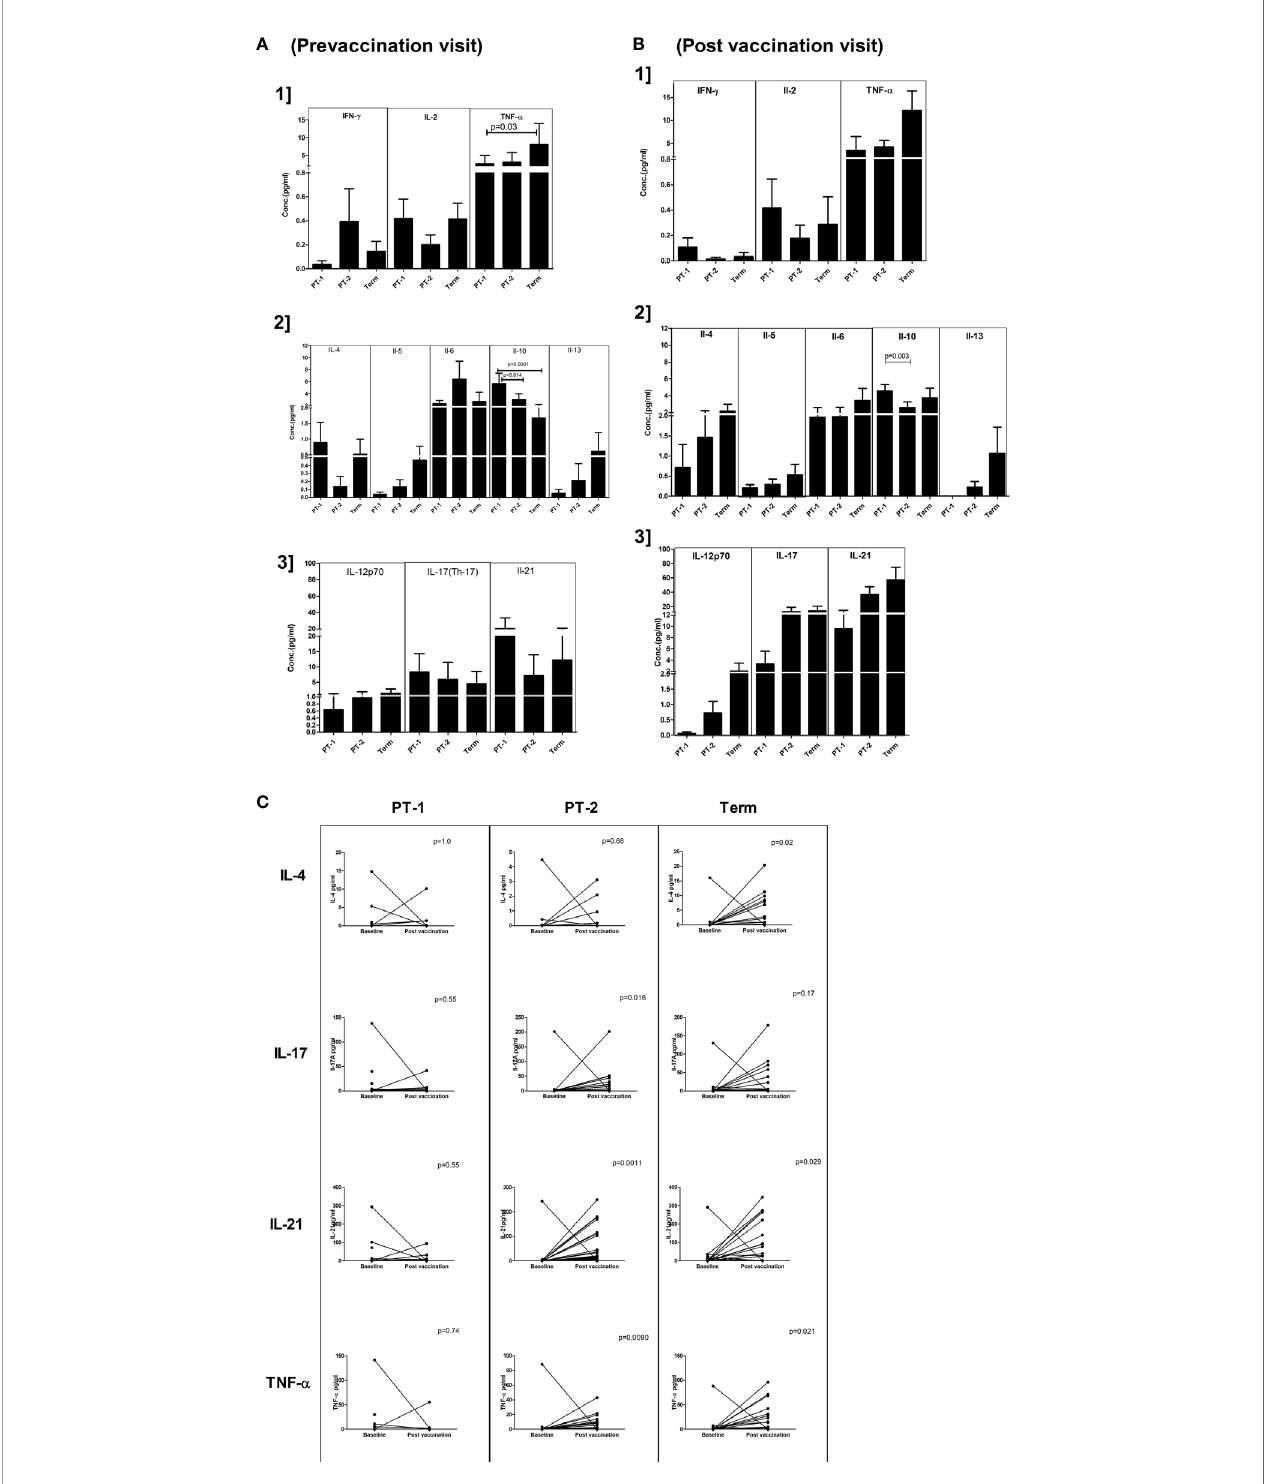
FIGURE 6 | Plasma cytokine levels in PT1, PT2 and FT infants prior to (A) and post- (B) pentavalent vaccination. The vertical column bar graphs represent A1] Th1 cytokines (IFN- g , IL-2, TNF- a ), A2] Th2 cytokines (IL-4, IL-5, IL-6, IL-10, IL-13) and A3] Th17 and miscellaneous cytokines before vaccination; B1, B2, and B3 plots present respective cytokines at post-pentavalent vaccination. (C) The line graphs denote the changes in plasma IL-4, IL-17, IL-21, and TNF- a levels in all the infant groups before and after pentavalent vaccination. Error bars- Mean with